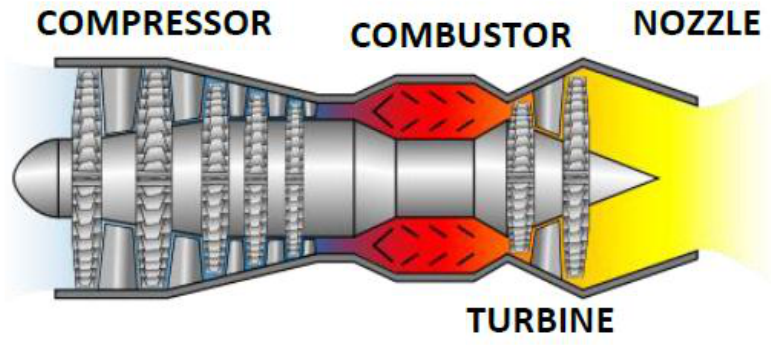
Figure 1. Turbojet engine schematic.